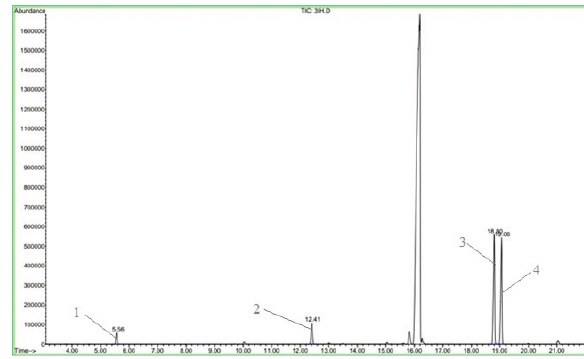
Figure 1. Chromatogram of carbohydrates formed as a result of enzymatic hydrolysis in the herbal mixture No. 3 (1 – arabinose, internal standard; 2 – glucose; 3–4 – fructose).